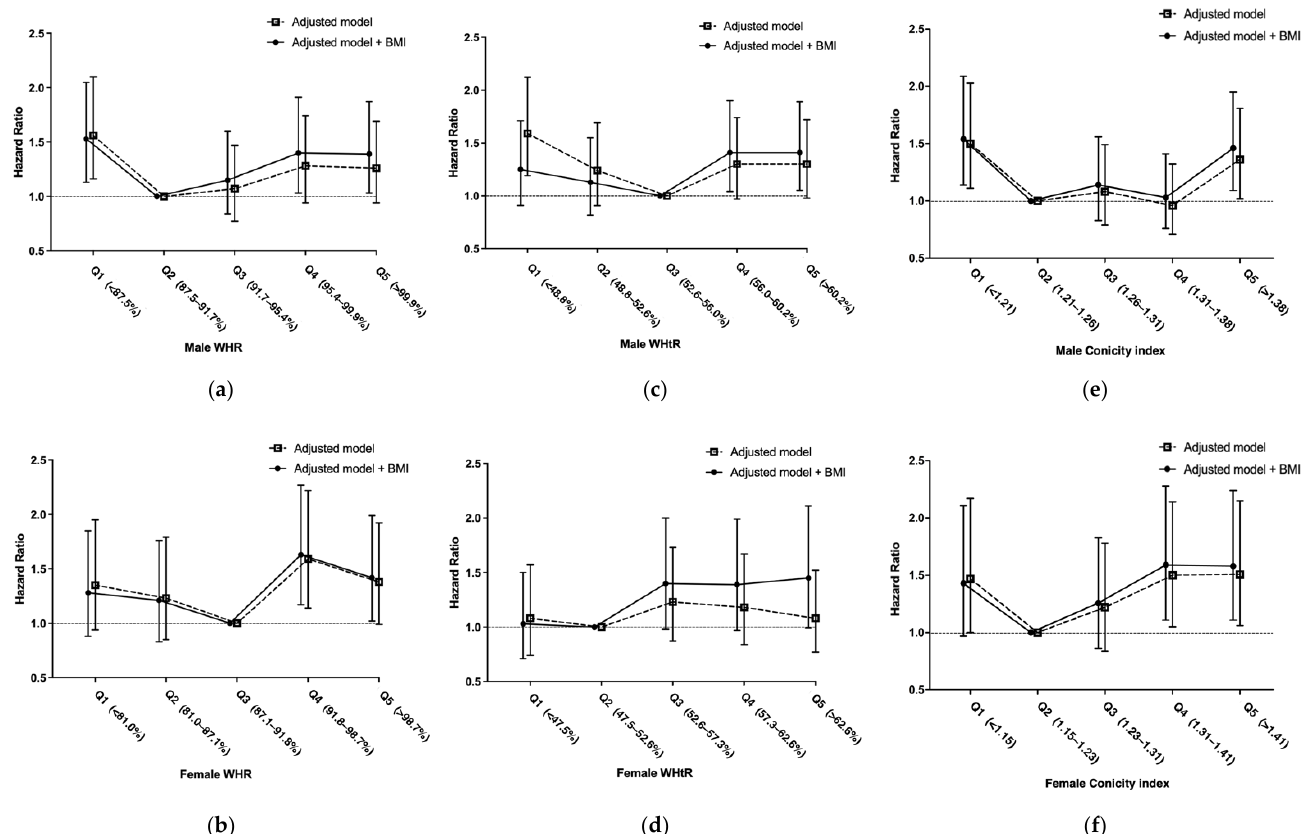
Figure 2. ( a ) HRs for mortality according to WHR in male patients before and after adjustment by BMI; ( b ) HRs for mortality according to WHR in female patients before and after adjustment by BMI; ( c ) HRs for mortality according to WHtR in male patients before and after adjustment by BMI; ( d ) HRs for mortality according to WHtR in female patients before and after adjustment by BMI; ( e ) HRs for mortality according to conicity index in male patients before and after adjustment by BMI; ( f ) HRs for mortality according to conicity index in female patients before and after adjustment by BMI. Abbreviations: BMI: body mass index, WHR: waist ‐ to ‐ hip ratio, WHtR: waist ‐ to ‐ height ratio, HHtR: waist ‐ to ‐ hip ratio.